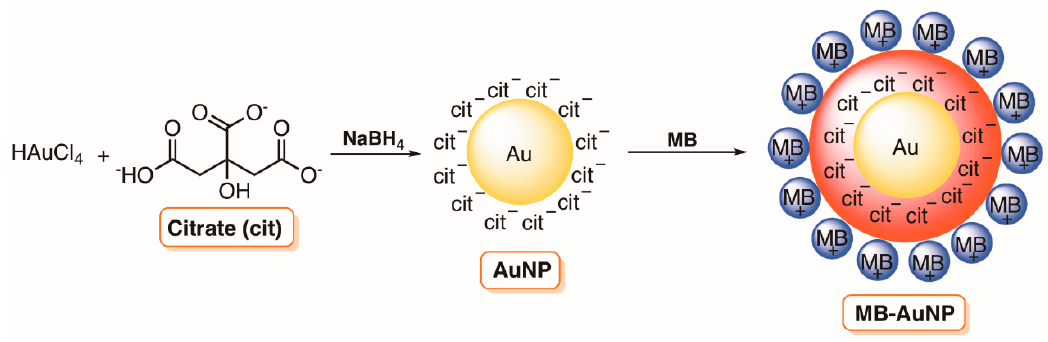
Figure 5. Schematic representation of the preparation of MB-AuNP conjugates (adapted from Reference [71]).